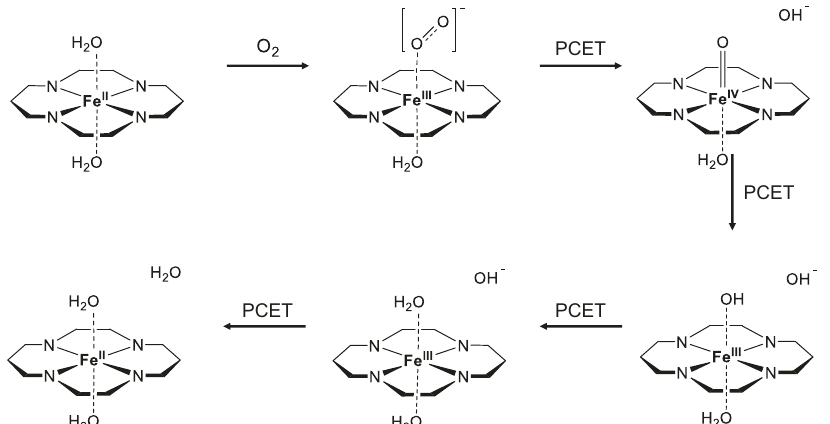
Fig. 7 Revised mechanism of ORR on FeN 4 in aqueous medium. For the convenience of view, the N-doped nanocarbon support is simpli fi ed into a simple